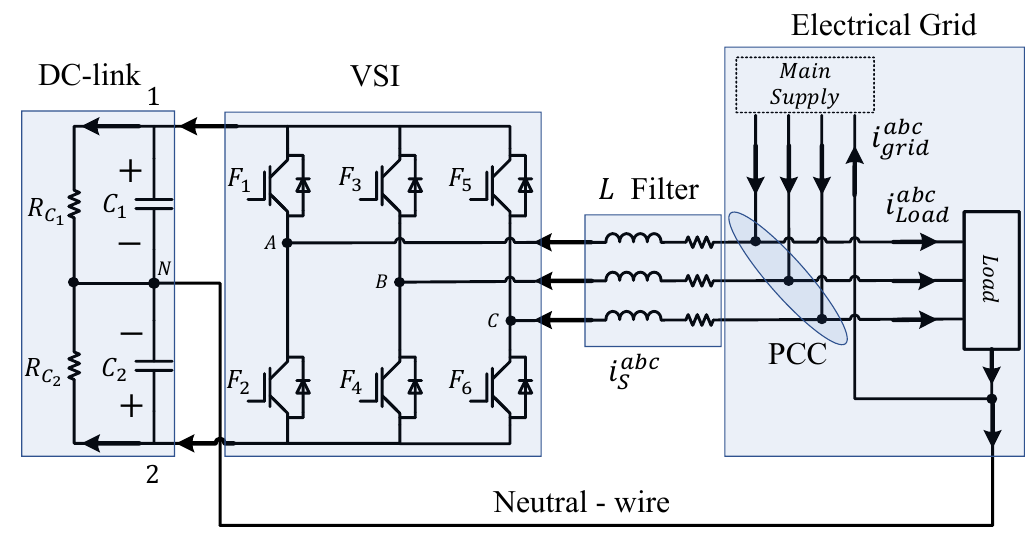
Figure 1. Three-Leg Split-Capacitor (TLSC) SAPF circuit